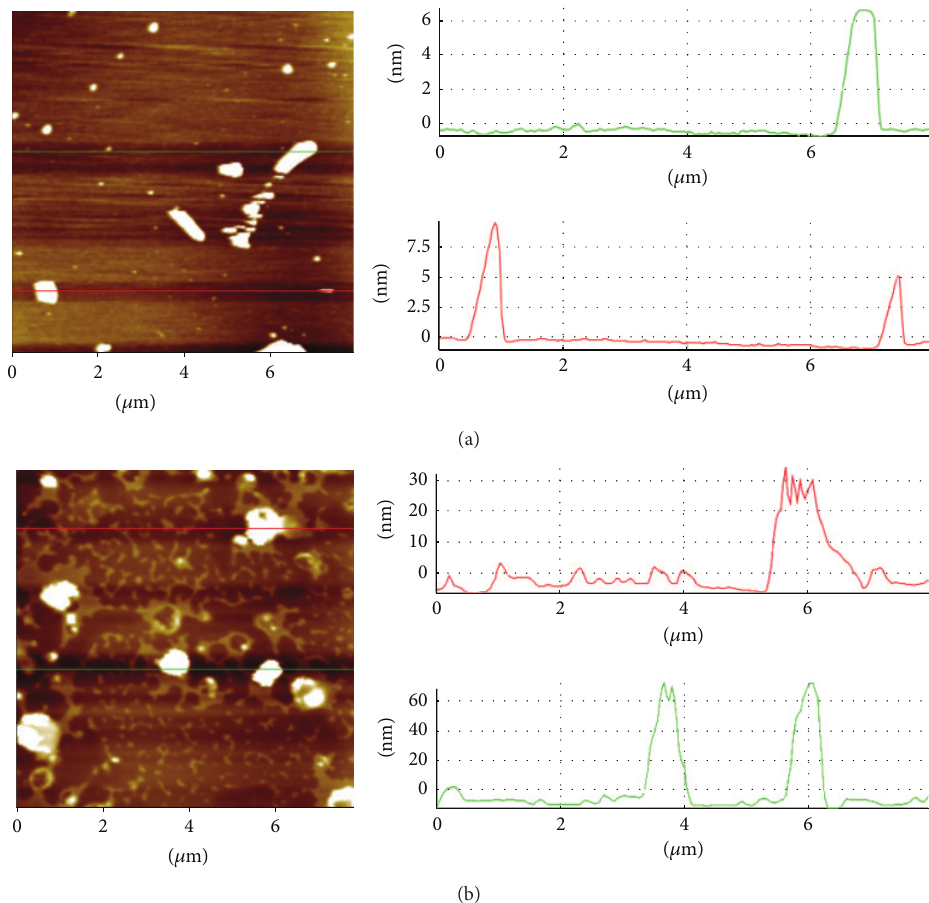
Figure 4: AFM images and height information of MPD micelles at 0.01 mM (a) and 0.1 mM